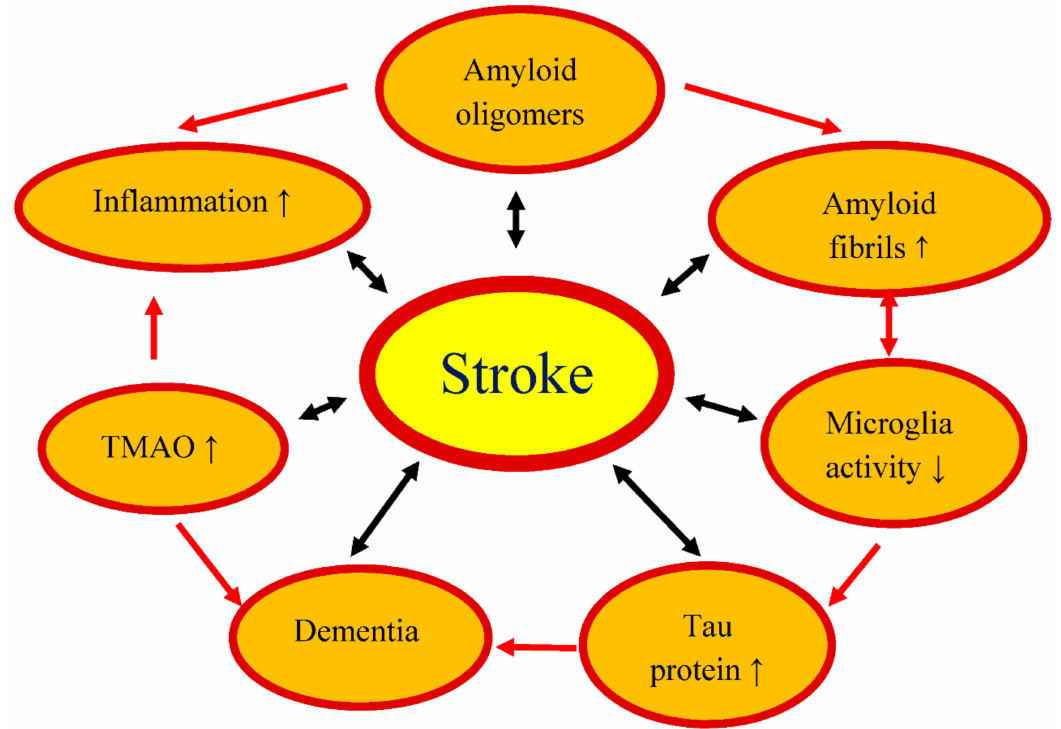
Figure 1. Influence of intestinal microflora dysbiosis on the development and outcome of an ischemic stroke. ↑ : increase, ↓ : decrease, TMAO: